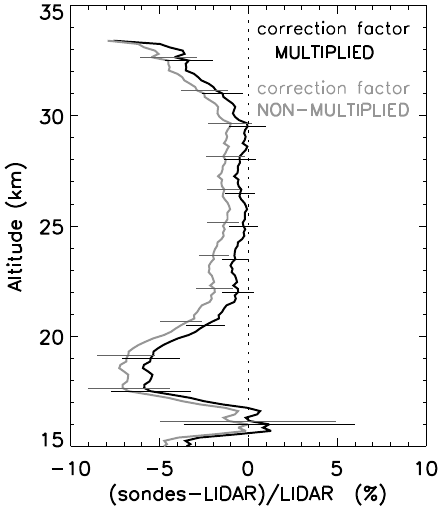
Fig. 9. Average relative deviation of ozone from lidar and ozonesondes, with and without multiplying by correction factor. The dotted vertical line represents 0% and the error bars represent twice the standard error.